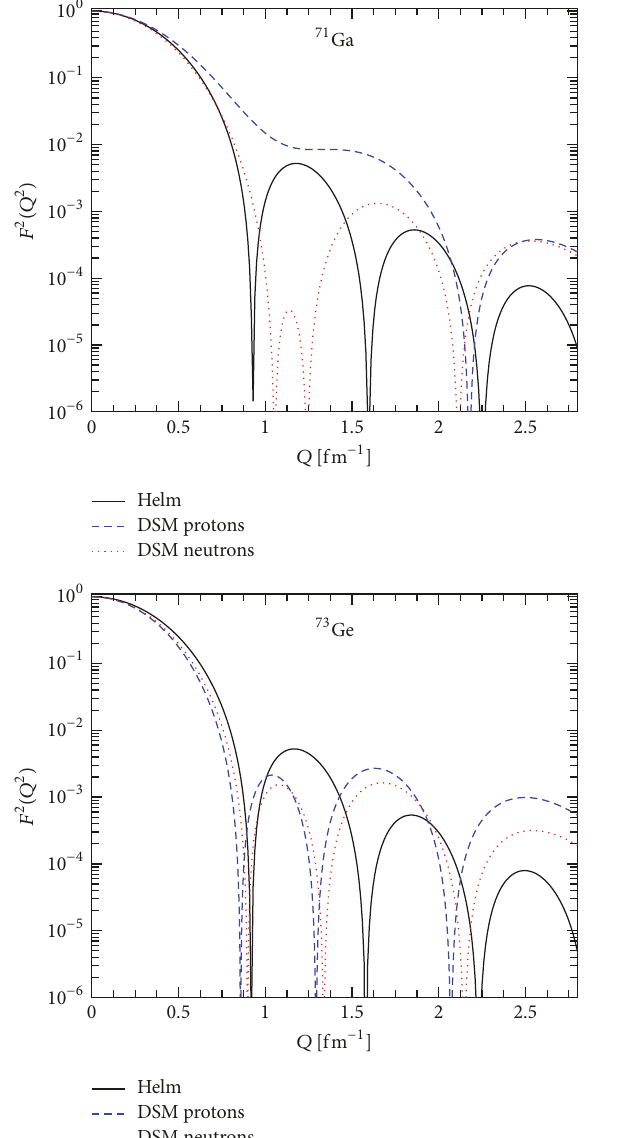
Figure 4: Comparison of the DSM nuclear form factors of the 71 Ga and 73 Ge isotopes, obtained in the present work with the corresponding effective Helm form factors.